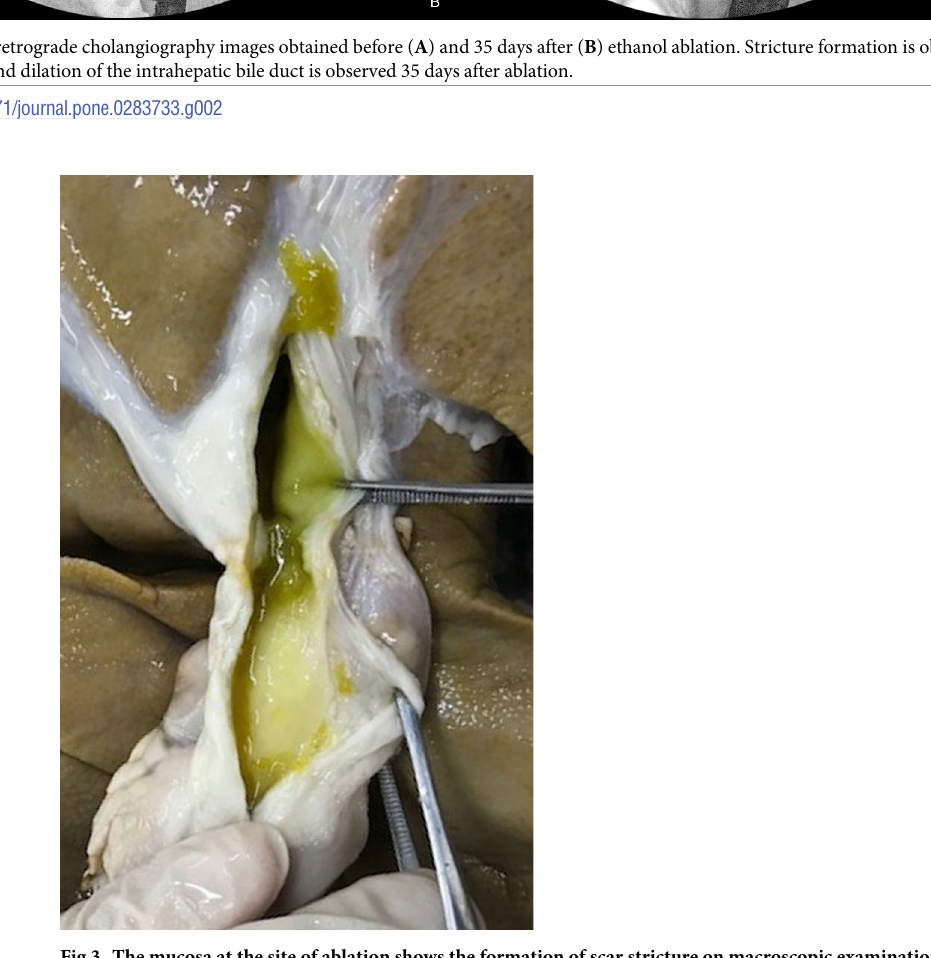
Fig 3. The mucosa at the site of ablation shows the formation of scar stricture on macroscopic examination 35 days after ethanol ablation.